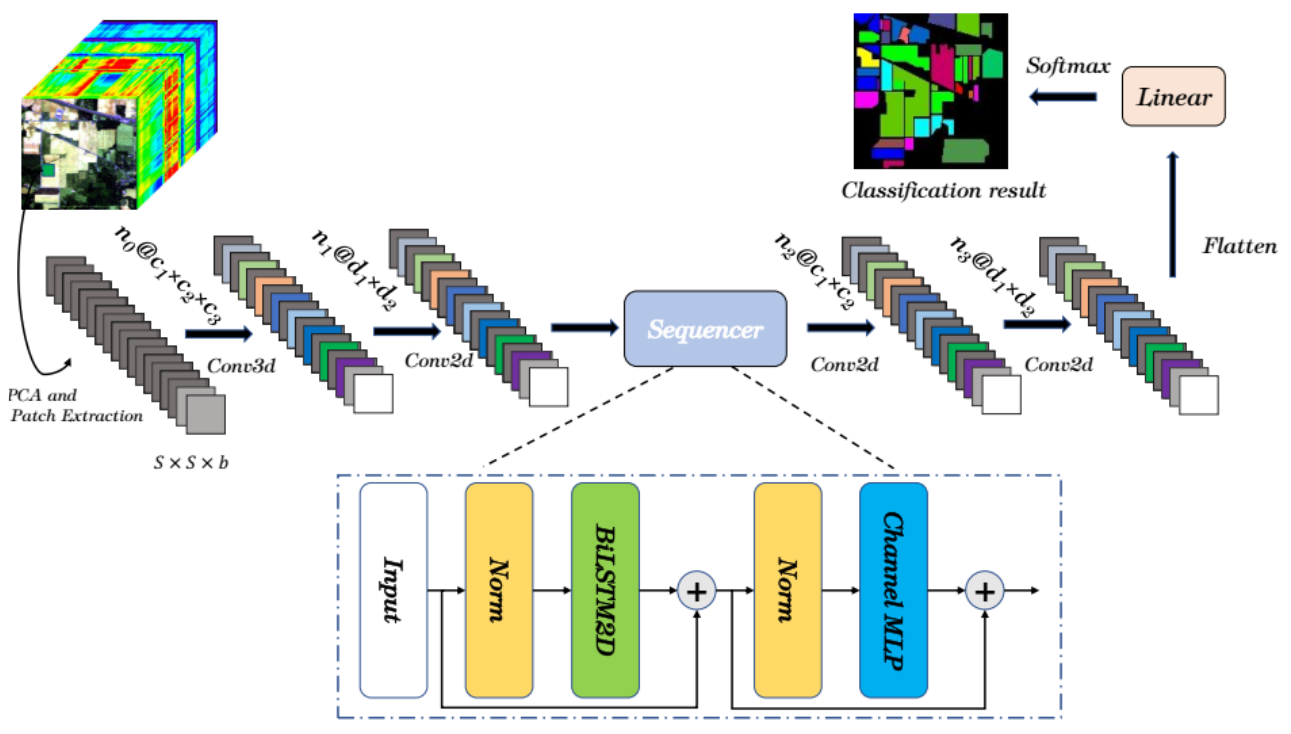
Figure 1. Illustration of the proposed